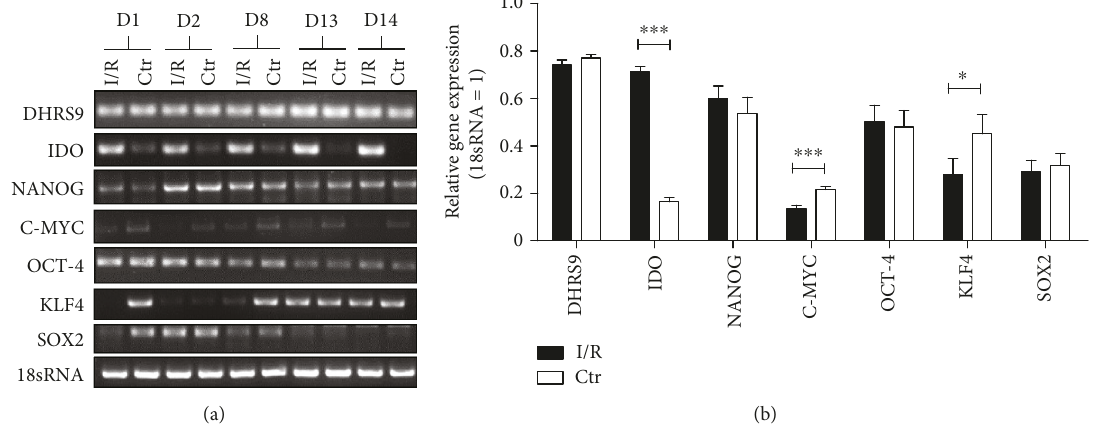
Figure 3: In fl uence of I/R on gene expression. (a) Respective PCR results from Mreg derived from 5 di ff erent donors (D1, D2, D8, D13, and D14). (b) Graphical and statistical analysis of gene expression in Mreg under control conditions and after I/R. I/R: ischemia/reperfusion; Ctr: control; ∗ p < 0 05 ; ∗∗∗ p < 0 001 ; N = 14